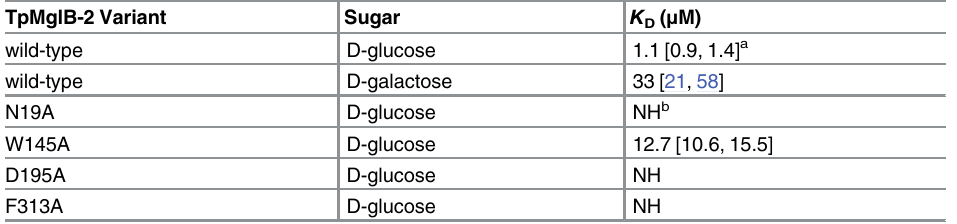
Table 3. Dissociation constants of the TpMglB-2/sugar